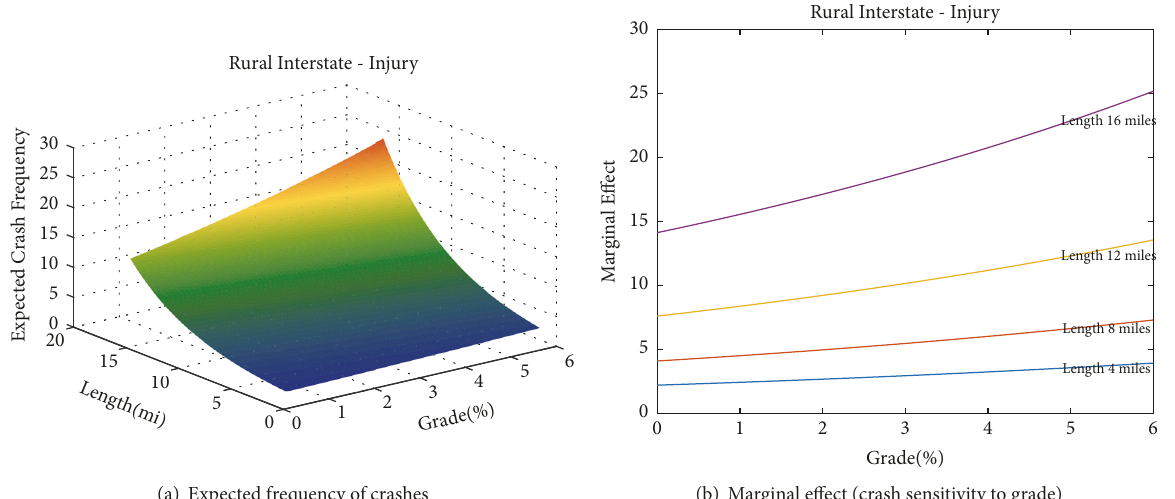
Figure 2: Rural interstate injury